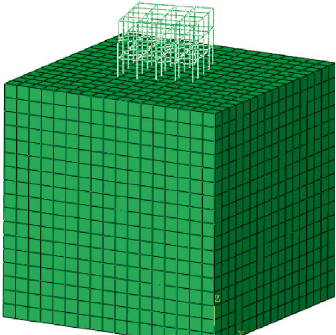
Figure 1: Finite element model of a stratum-structure geotechnical